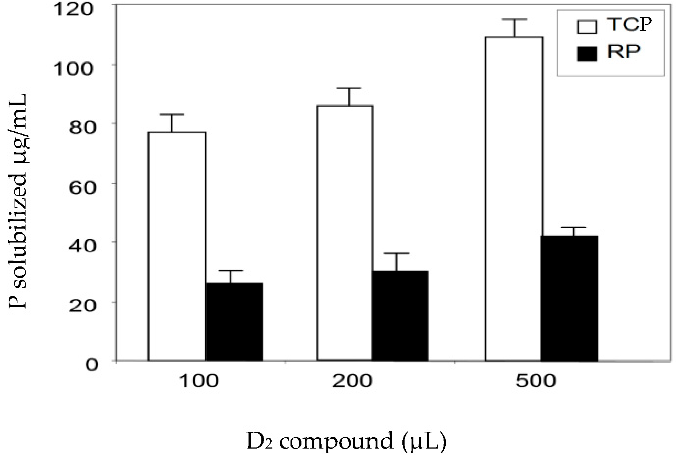
Figure 3. Phosphate released from TCP (4 mg/mL, white histograms) and RP (1 mg/mL, black histograms) incubated for five days at 30 ◦ C on a rotary shaker (180 rpm) in the presence of 100, 200, and 500 µ L of purified compound D 2 or an equivalent volume of sterile bi-distilled water (negative control). The amount of soluble phosphate released from RP and TCP of the negative control was subtracted from that present in the assays containing the purified compound D 2 . The final values are arithmetic means of three independent assays and error bars represent standard deviations of the mean values of the